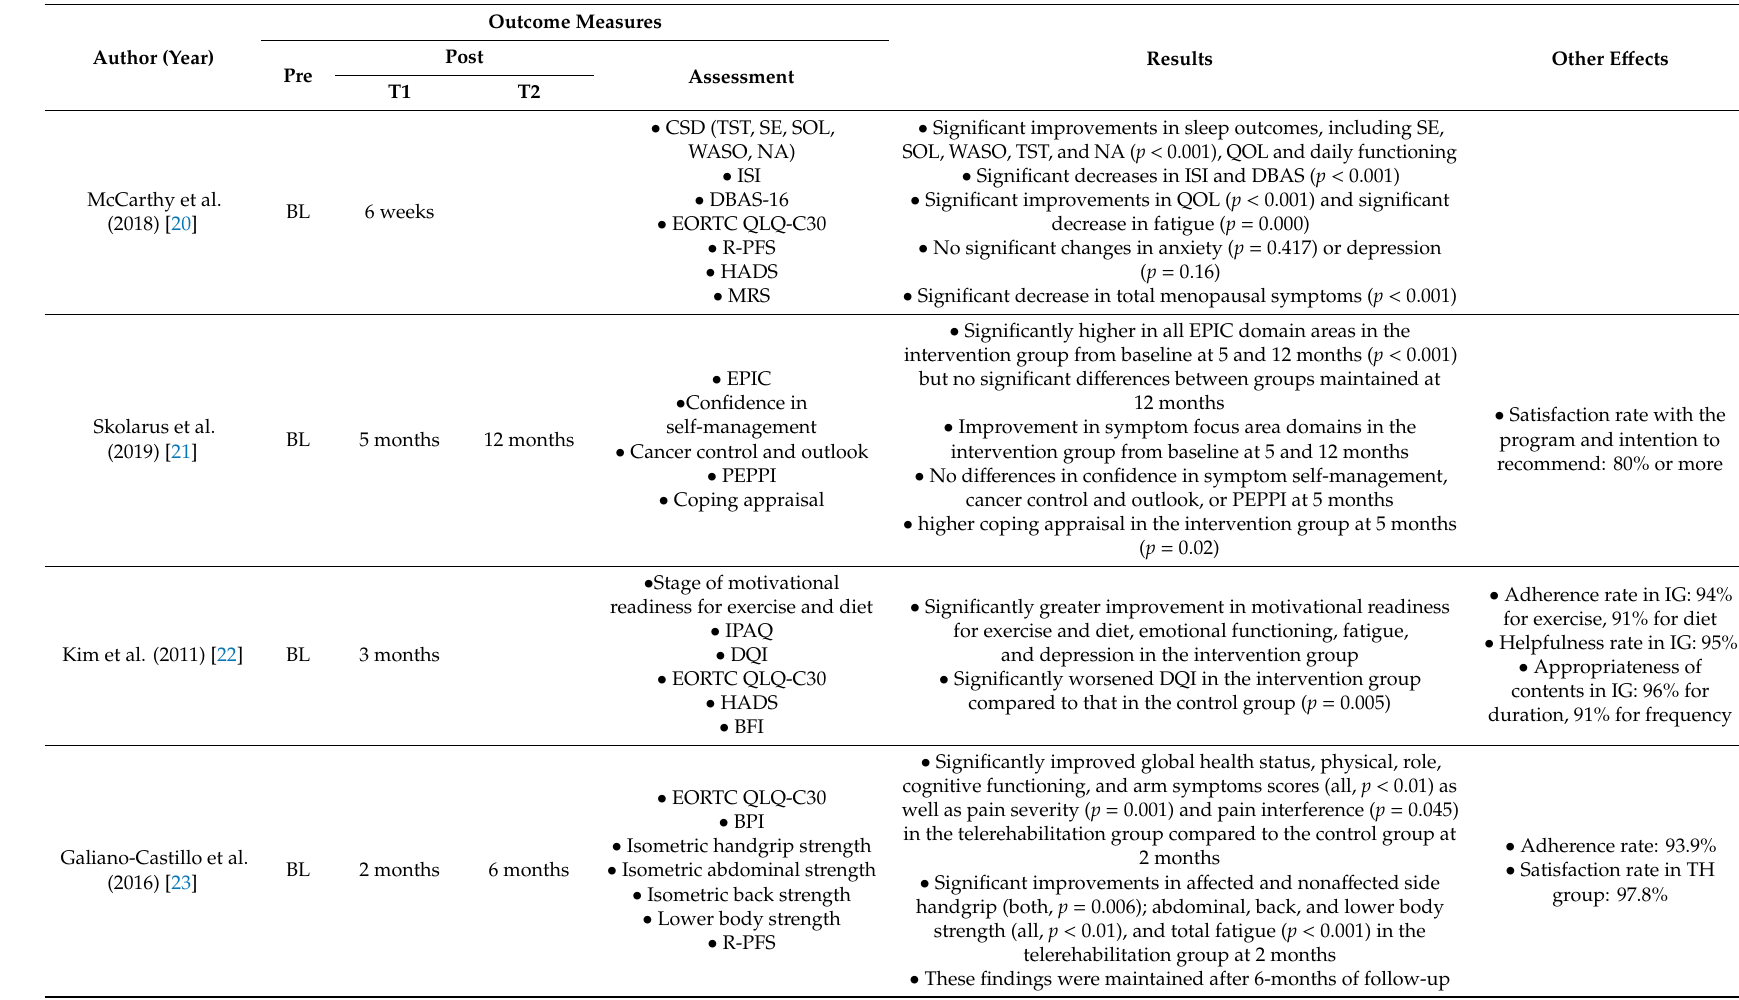
Table 3. Summary of results of the included